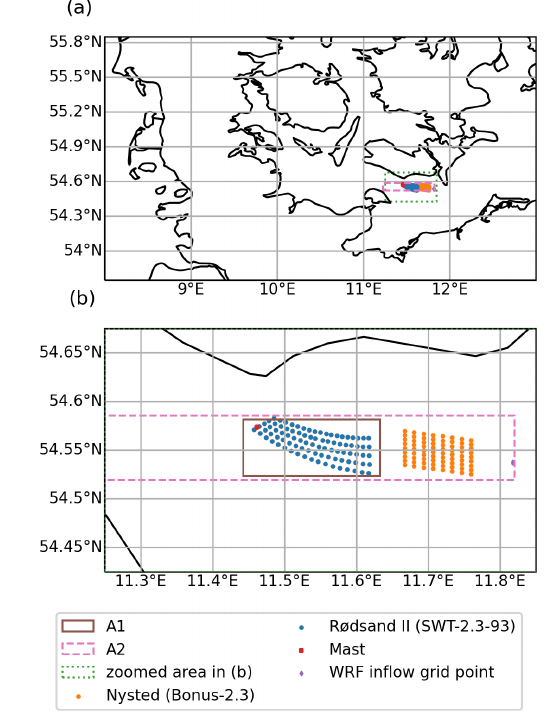
Figure 2. The study area, Fehmarn Belt, with wind farms and mast location. Panel (b) is a zoom of the dotted green area in (a) . The dot in the east refers to the WRF grid point used for the filtering in Sect. 2.2.3. The solid and dashed rectangles A1 and A2 are used for the analysis of the farm-to-farm wake effect in Fig. 15. Details of the wind farms are given in Table 1.